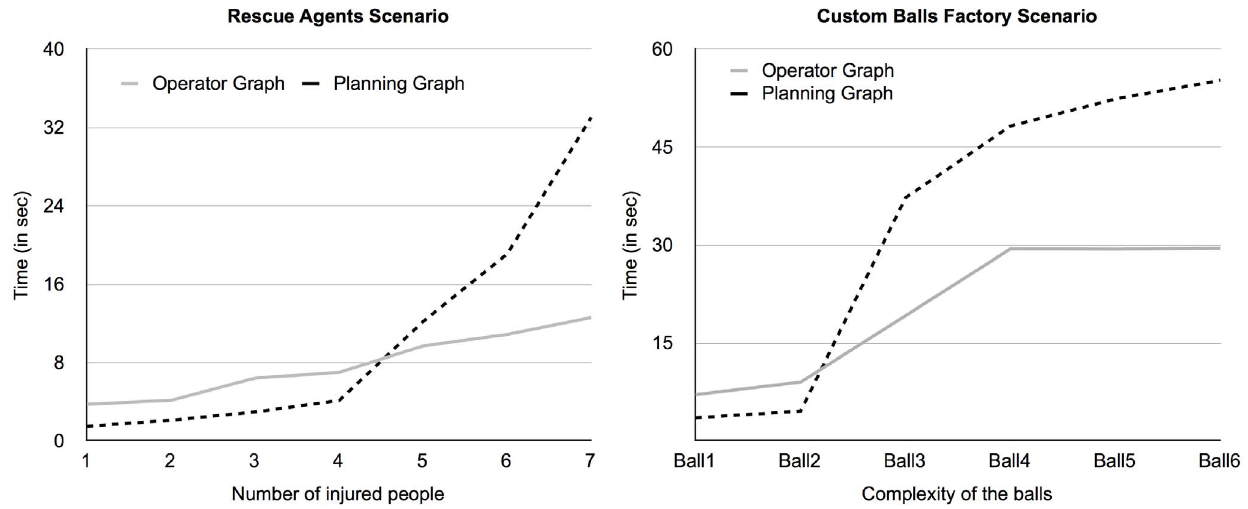
Figure 1. Comparison between the two algorithms in both testing scenarios. Comparison between Distributed Graphplan and Operators- graph-based Distributed Graphplan in both testing scenarios, with the Rescue Agents scenario on the left panel and the Custom Balls Factory scenario on the right panel.